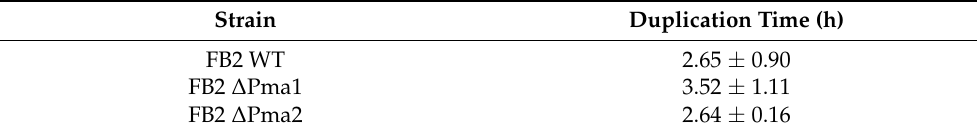
Figure 1. Ustilago maydis growth and basal metabolism. U. maydis wild-type and mutant cells were grown in 25 mL of YPD media at 28 ◦ C. Aliquots were collected at 0, 2, 24, 48, and 72 h to measure ( A ) optical density at 600 nm, ( B ) the residual glucose concentration in the culture media; the initial concentration of glucose was 55.6 mM, and ( C ) oxygen consumption rate was expressed as µmol O 2 •(min•mg dry weight sporidia) −1 . One-way ANOVA analysis was carried out to uncover significant differences among the oxygen consumption rates of the three strains. No statistically significant difference was found between strains using p < 0.05 as a threshold. Data were obtained from three or more independent experiments (n ≥ 3). Table 3. Duplication times of Ustilago maydis